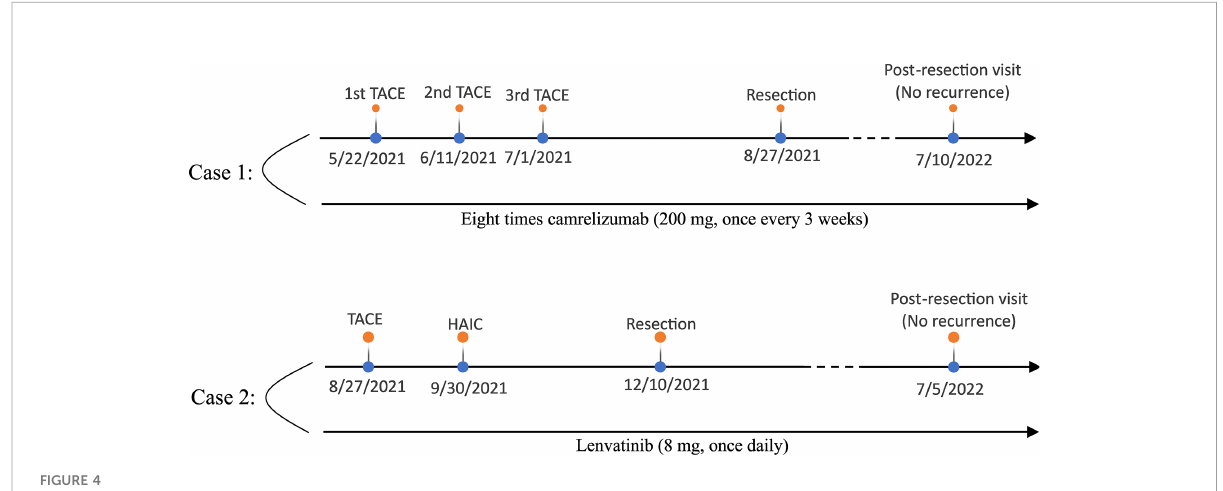
FIGURE 4 The treatment timeline of the two patients (top: case 1; below: case